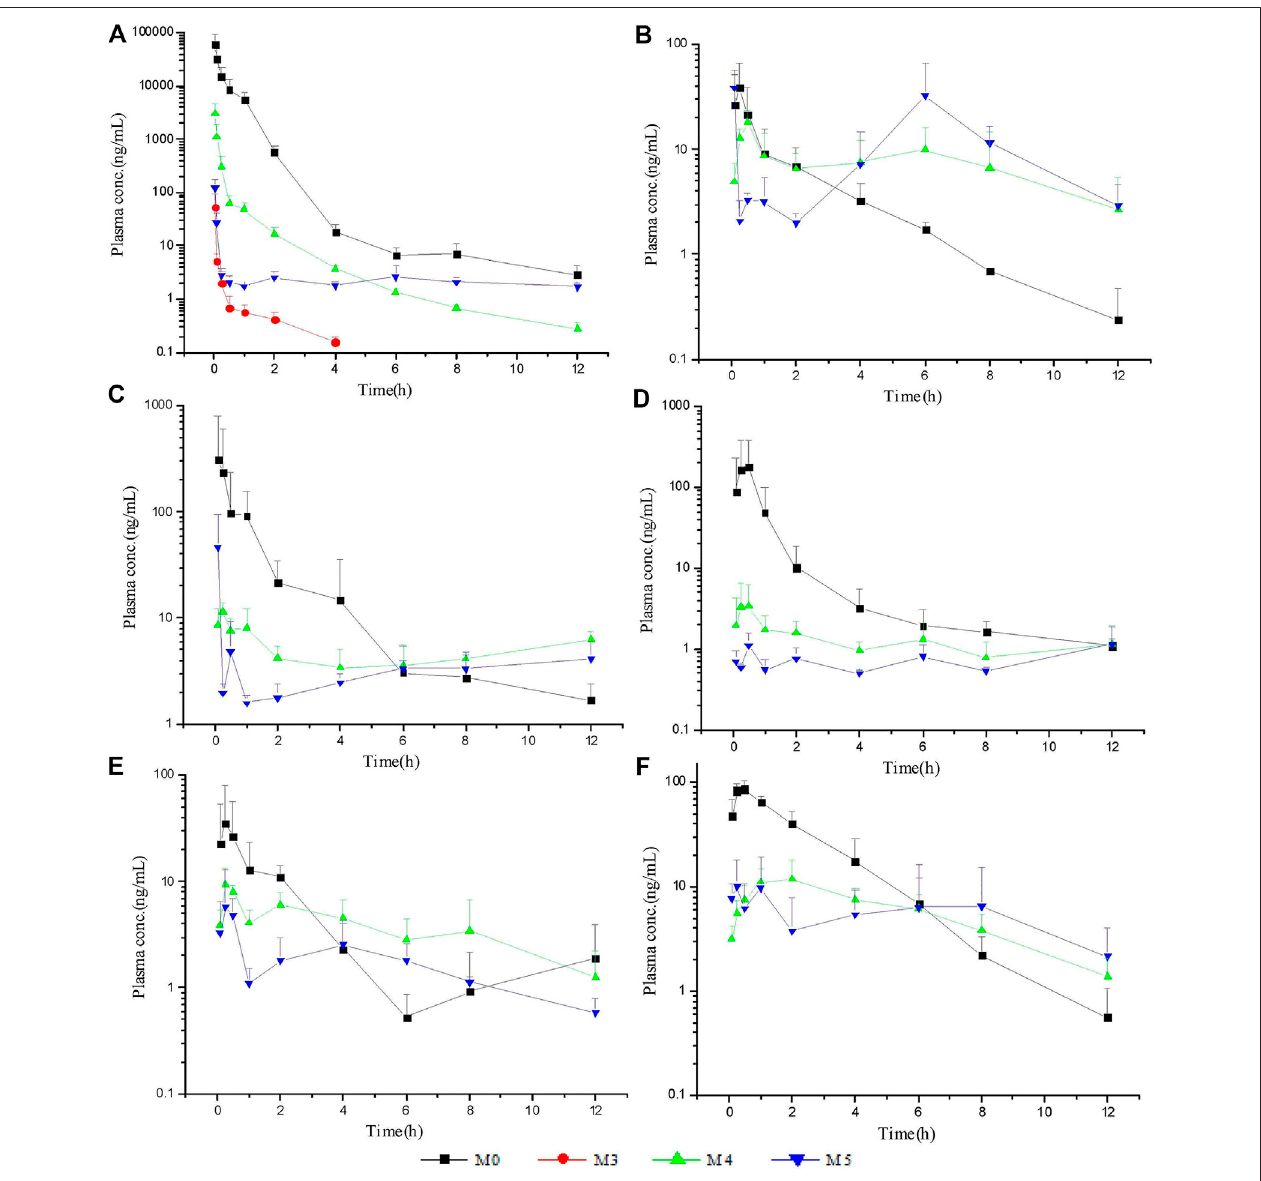
FIGURE 5 | Mean plasma concentration-time pro fi les of ASD and metabolites: intravenous administration (A) at a dose of 10 mg/kg; intragastrical administration (B) and combined intragastrical administration with vegetable oil (C) , metronidazole (D) , verapamil (E) , urea (F) at a dose of 100 mg/kg ( n (cid:2) 5).